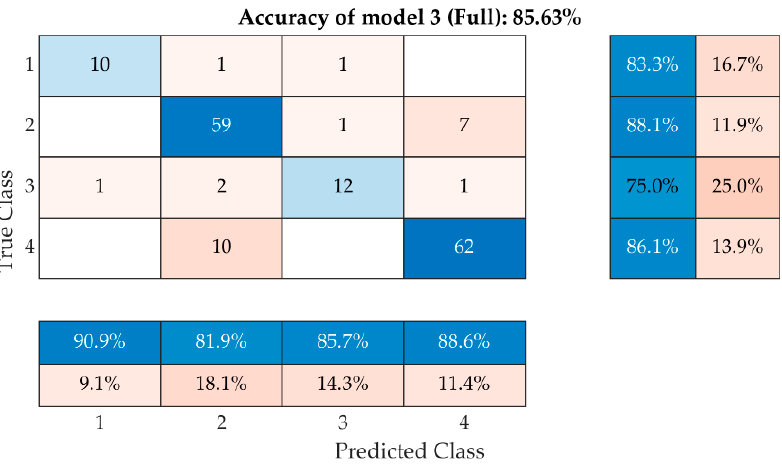
Figure 19. Confusion matrix of the most effective model with all known parameters.